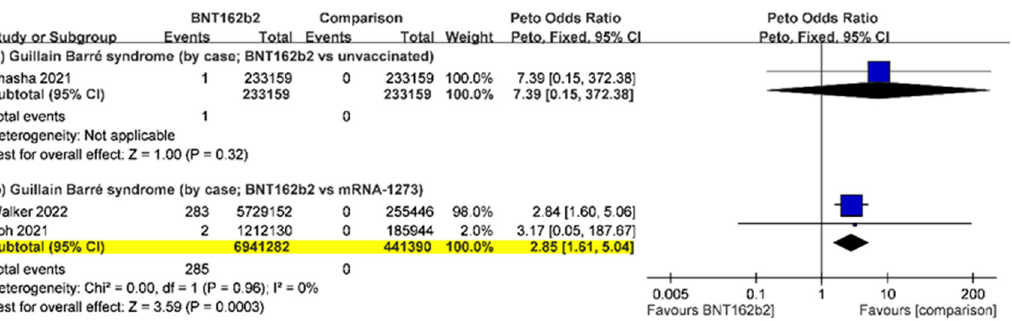
Figure 3. Forest plot analysis of the incidence of Guillain–Barré syndrome after the administration of BNT162b2 versus other comparison. Statistical significance is highlighted in yellow.